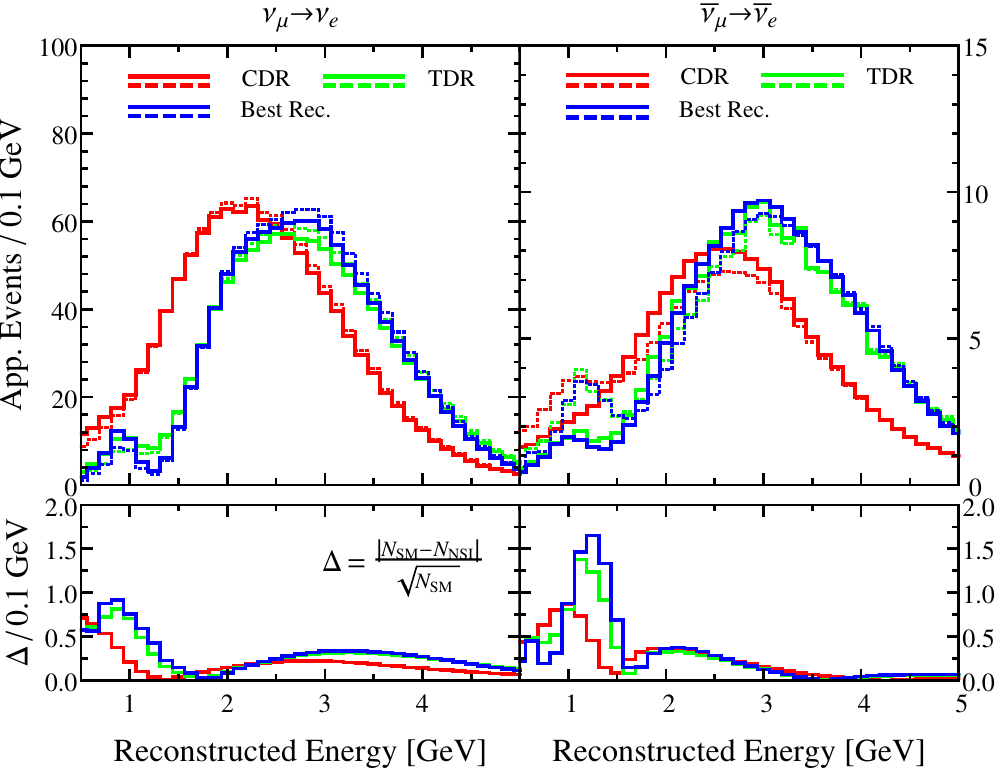
Figure 9 . Upper left (right) panel presents the ν µ → ν e ( ¯ ν µ → ¯ ν e ) appearance event spectra as a function of reconstructed energy. Red, green and blue lines correspond to the CDR, TDR, and Best Reconstruction configurations, respectively. Solid lines represent the standard three-neutrino spectra with δ CP = − 90 ◦ and dashed lines represent the spectra with NSI in the e − τ sector. In case of NSI, we have taken the best fit parameters corresponding to the black triangle in figure 8, i.e., δ CP = − 35 ◦ , | ε eτ | = 0 . 16 , and φ eτ = 10 ◦ for the CDR, and φ eτ = 15 ◦ for the TDR and Best Reconstruction cases. The best fit values of θ 13 , θ 23 , and ∆ m 2 have also been chosen from 31 the simulation. Lower left (right) panel represents the absolute difference in the upper left (right) appearance events between the standard and the NSI scenarios divided by the statistical uncertainty in each bin. The color coding is the same as in the upper